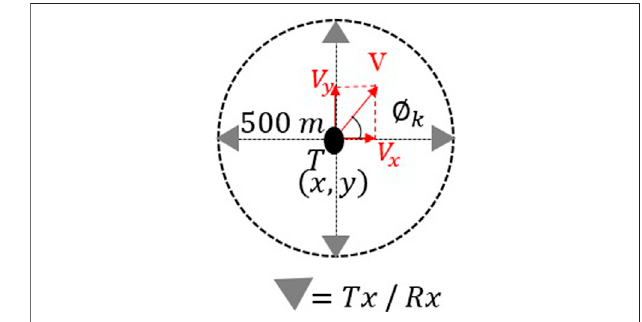
FIGURE 2 | Antenna